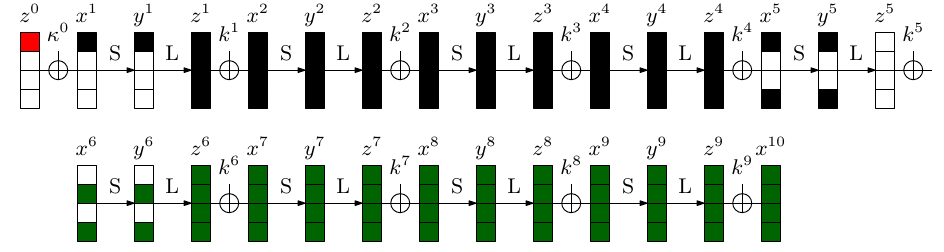
Figure 8: Generalized Demirci-Selçuk attack on 9 round version of